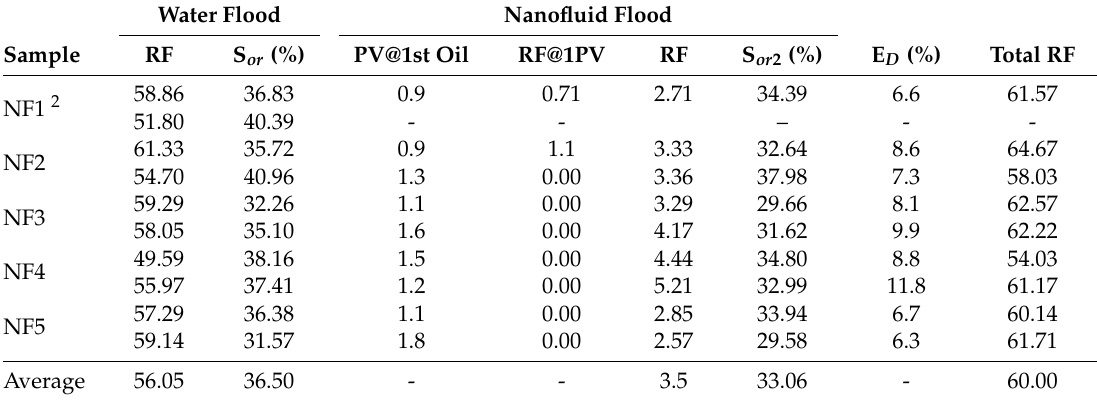
Table 6. Oil recovery factors (water and nanofluid flooding), expressed as percent of OOIP, and S or achieved at the end of core flooding in neutral-wet